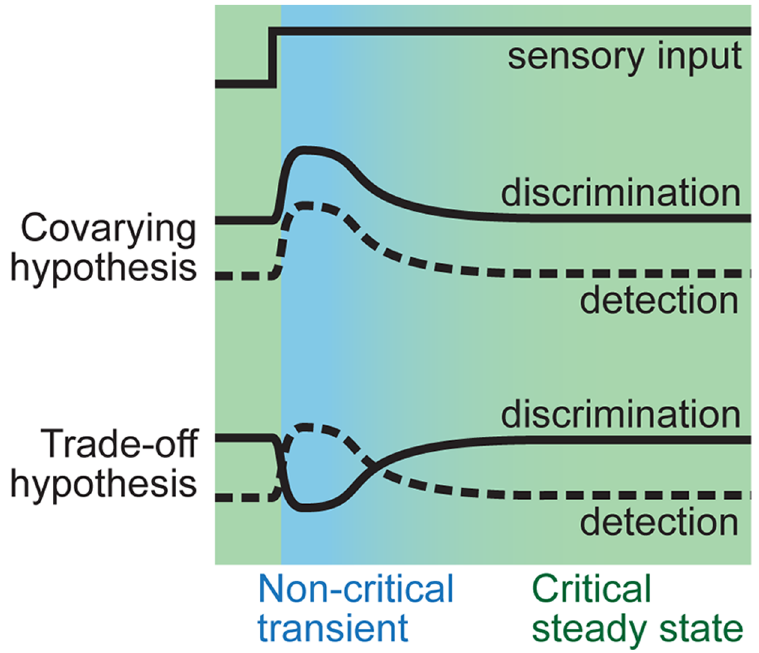
Fig 1. Hypothesized relationships between stimulus discrimination and detection during adaptation. Cartoonillustrationof how the gross detectionof input may differ from the ability to discriminate fine input differences duringadaptation followingstimulus onset. One possibility–the covaryinghypothesis–is that the highlyactive transient responsecarries the most information about the stimulus regardlessof whetherwe considerdiscrimination or detection. In this view, adaptivedepression of synapses reducesinformation transmission and the critical dynamics of the steady state are too noisy for effective discrimination. Alternatively, the trade-off hypothesis is that the strong onset response is good for detection, but lacks the selectivity neededfor good discrimination. This view is in line with the predictionthat the critical dynamics of the steady state optimize information